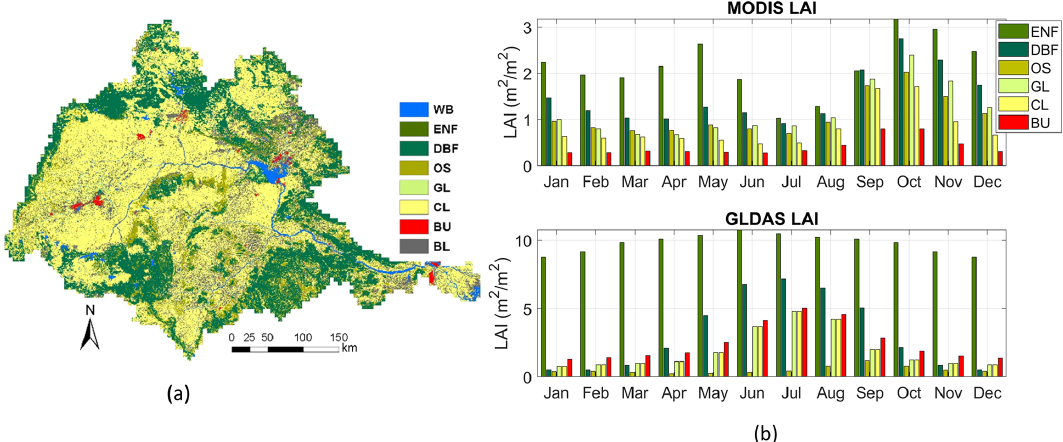
Figure 2. (a) LULC map of Mahanadi river basin from NRSC of year 2005. (b) Comparison of LAI values from MODIS, averaged over the time period 2000–2015, and